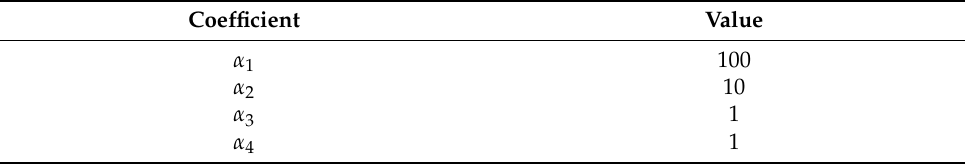
Table 2. Weights of the objective function.